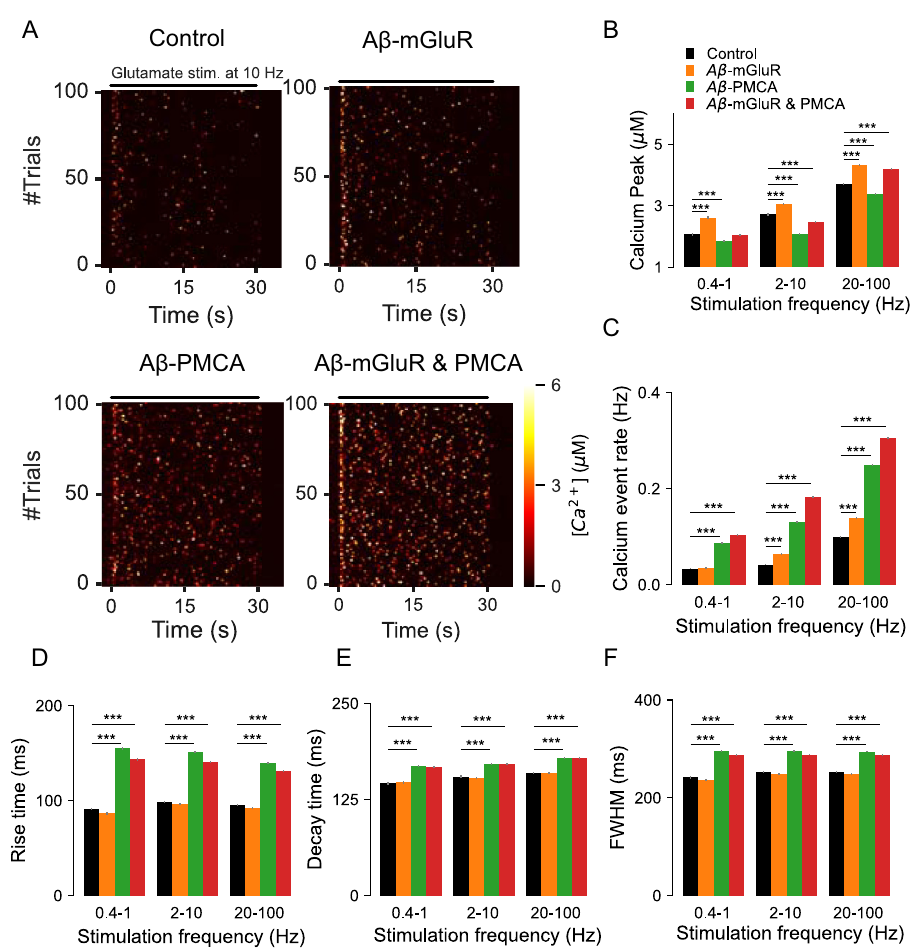
Fig 5. Quantification of the dynamics and kinetics of Ca 2+ events from astrocytic compartments stimulated with glutamate vesicles. (A) Representative heat maps highlight the differences in Ca 2+ dynamics in the presence of A β conditions. (B) Peak Ca 2+ amplitude averaged across different ranges of stimulation frequencies. (C) Glutamate- evoked Ca 2+ events are more frequent in astrocytes with A β conditions when compared to control. (D) The presence of A β -PMCA condition increases the (E) rise time, (F) decay time and (F) Full width at half maximum of astrocytic Ca 2+ events. Error bars indicate the standard error of the mean from 6 independent datasets.